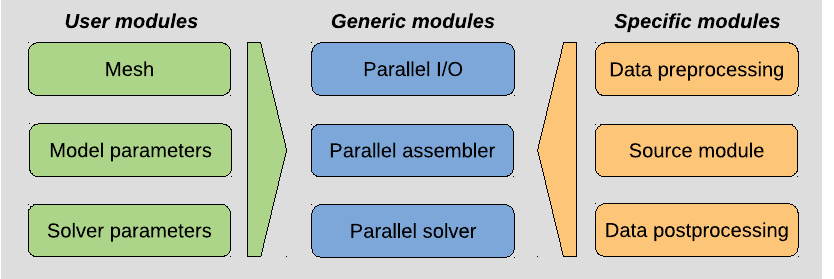
Figure 1. environment overview. This work-flow supports both 3D CSEM and MT survey